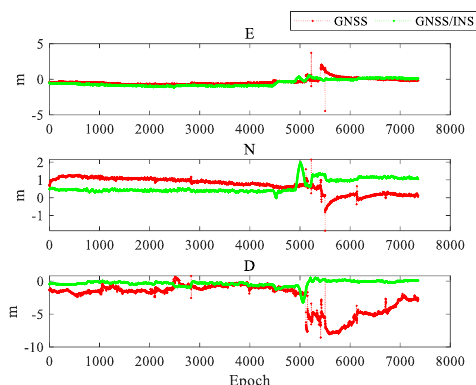
Figure 4 . Position error of GNSS and GNSS/INS tightly- coupled in END direction